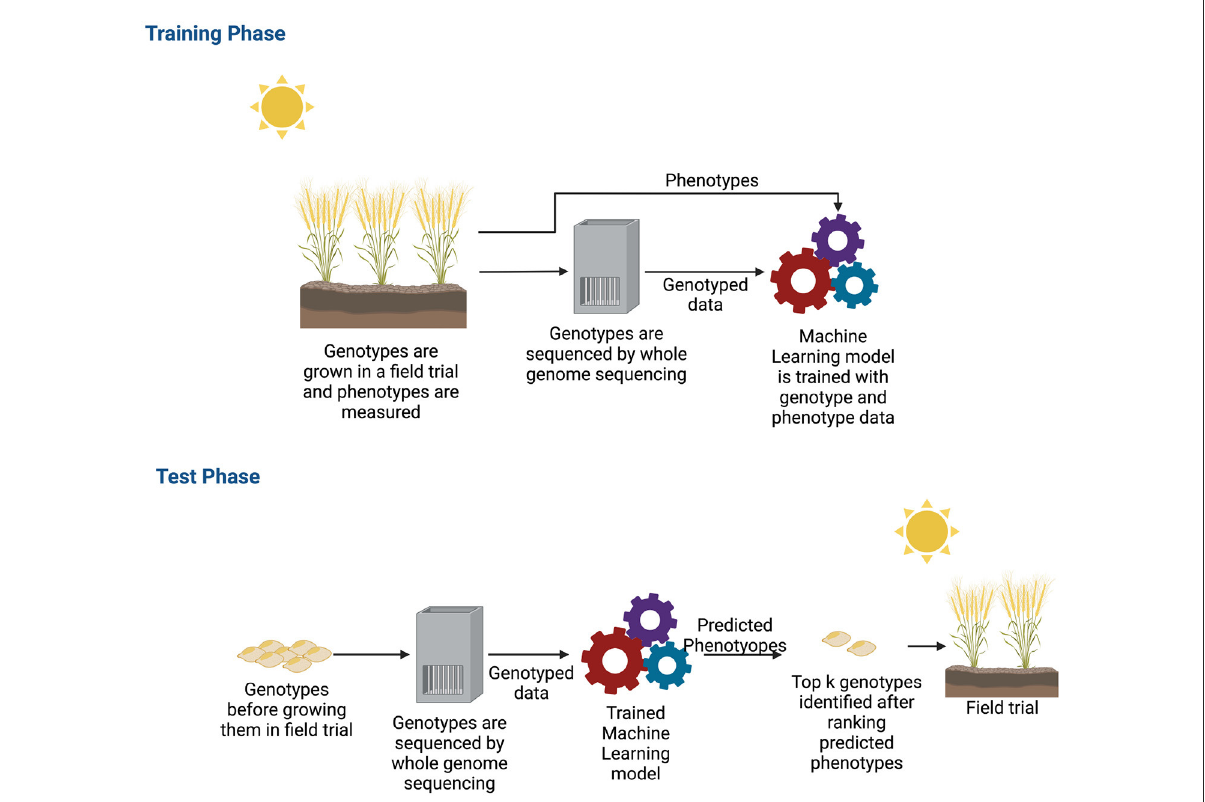
FIGURE5 Workflow of genomic selection in single environment trial. For collecting training data, plants are grown in a field trial and phenotypes were measured. These plants are also genotyped. After obtaining both genotyped and phenotyped data, a machine learning model is trained during the training phase with both types of data. After the machine learning model is trained, potential genotypes that will be grown in the field are genotyped. These genotyped data are the input to the trained machine learning model. The machine learning model estimates the phenotypes. The estimated phenotypes are ranked and the top k phenotypes are chosen to select new varieties that will be grown in the